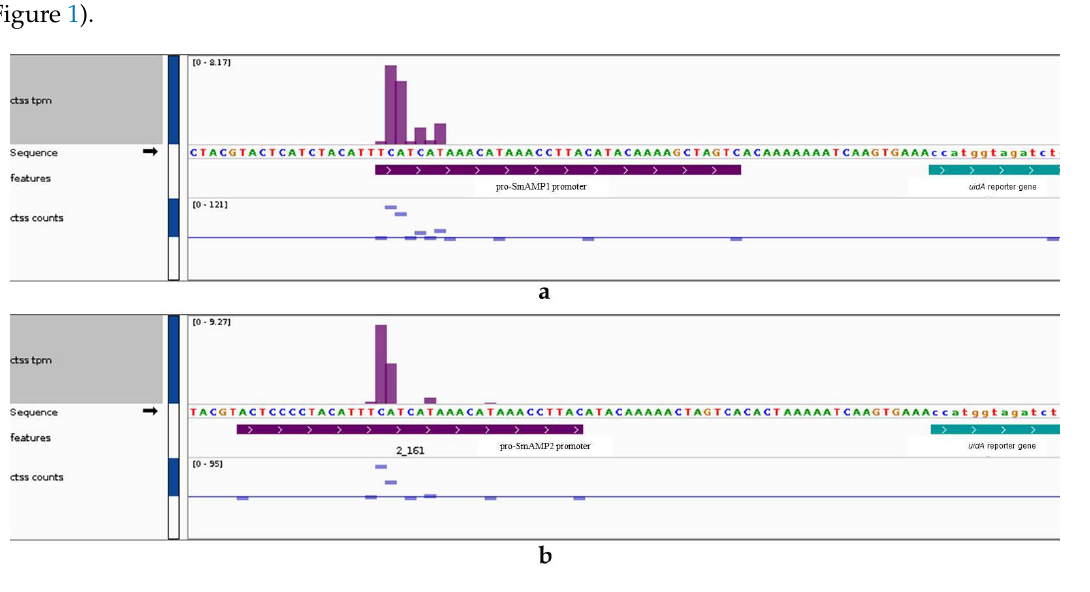
Figure 1. Cap analysis of gene expression data from pro-SmAMP1 ( a ) and pro-SmAMP2 ( b ) promoters in aseptic transgenic tobacco plants.